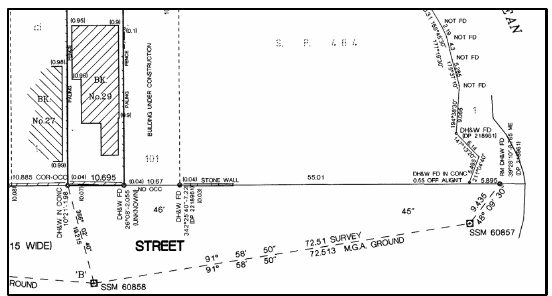
Figure 4: A plan showing survey control lines Each floor plan in the strata entitlement was